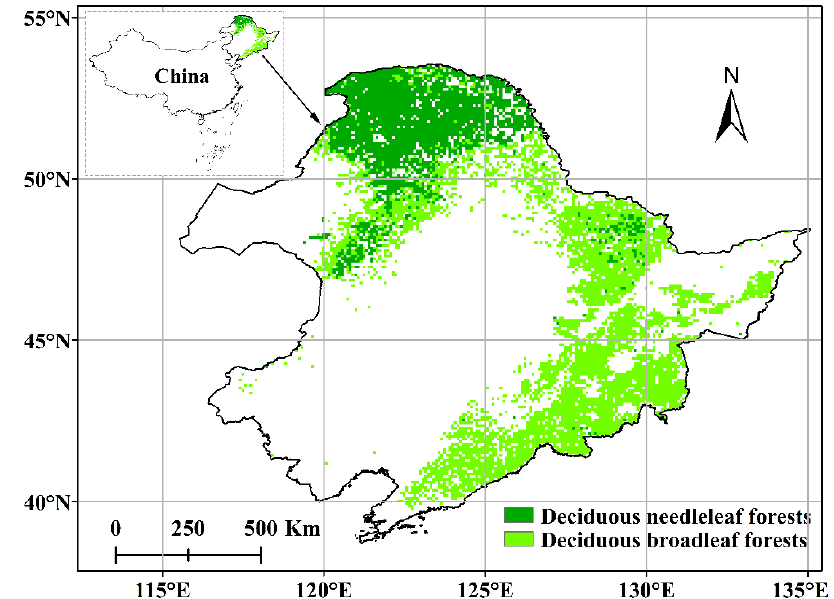
Figure 1. Location of study area and distribution range of two forest types .